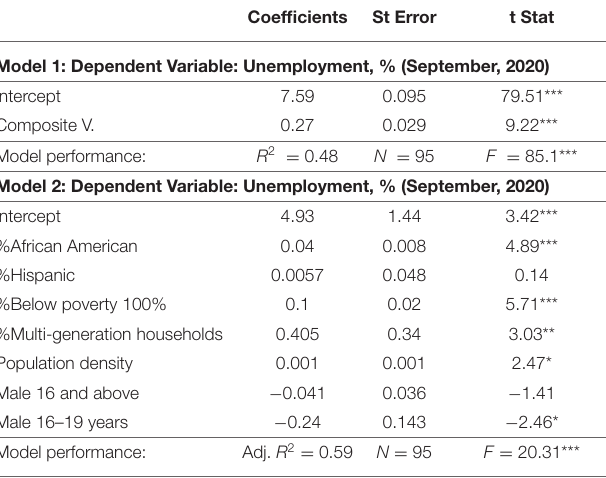
TABLE 3 | Results of the regression analysis.